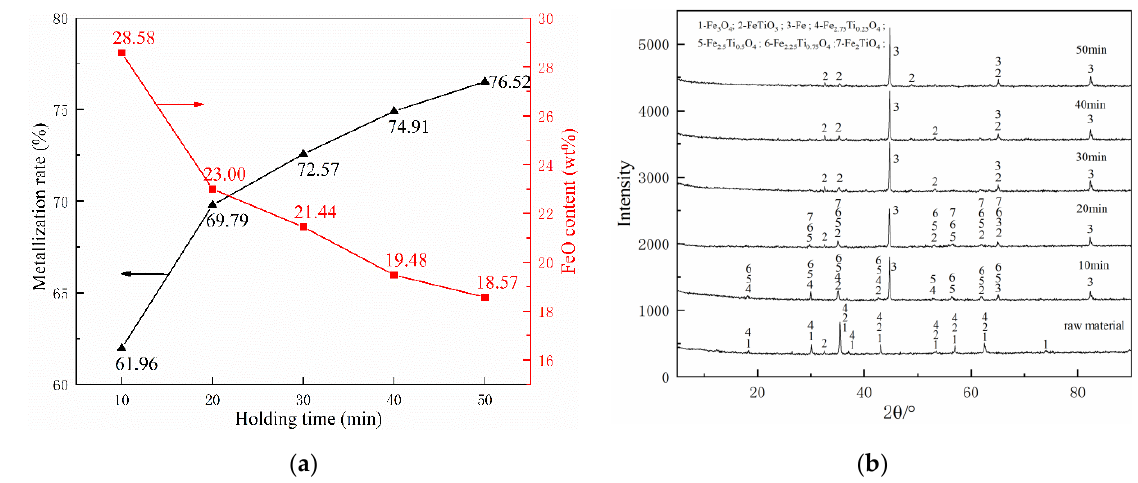
Figure 7. Effects of reduction holding time on composite’s behaviors: ( a ) metallization ratio and FeO content and ( b ) phase change.